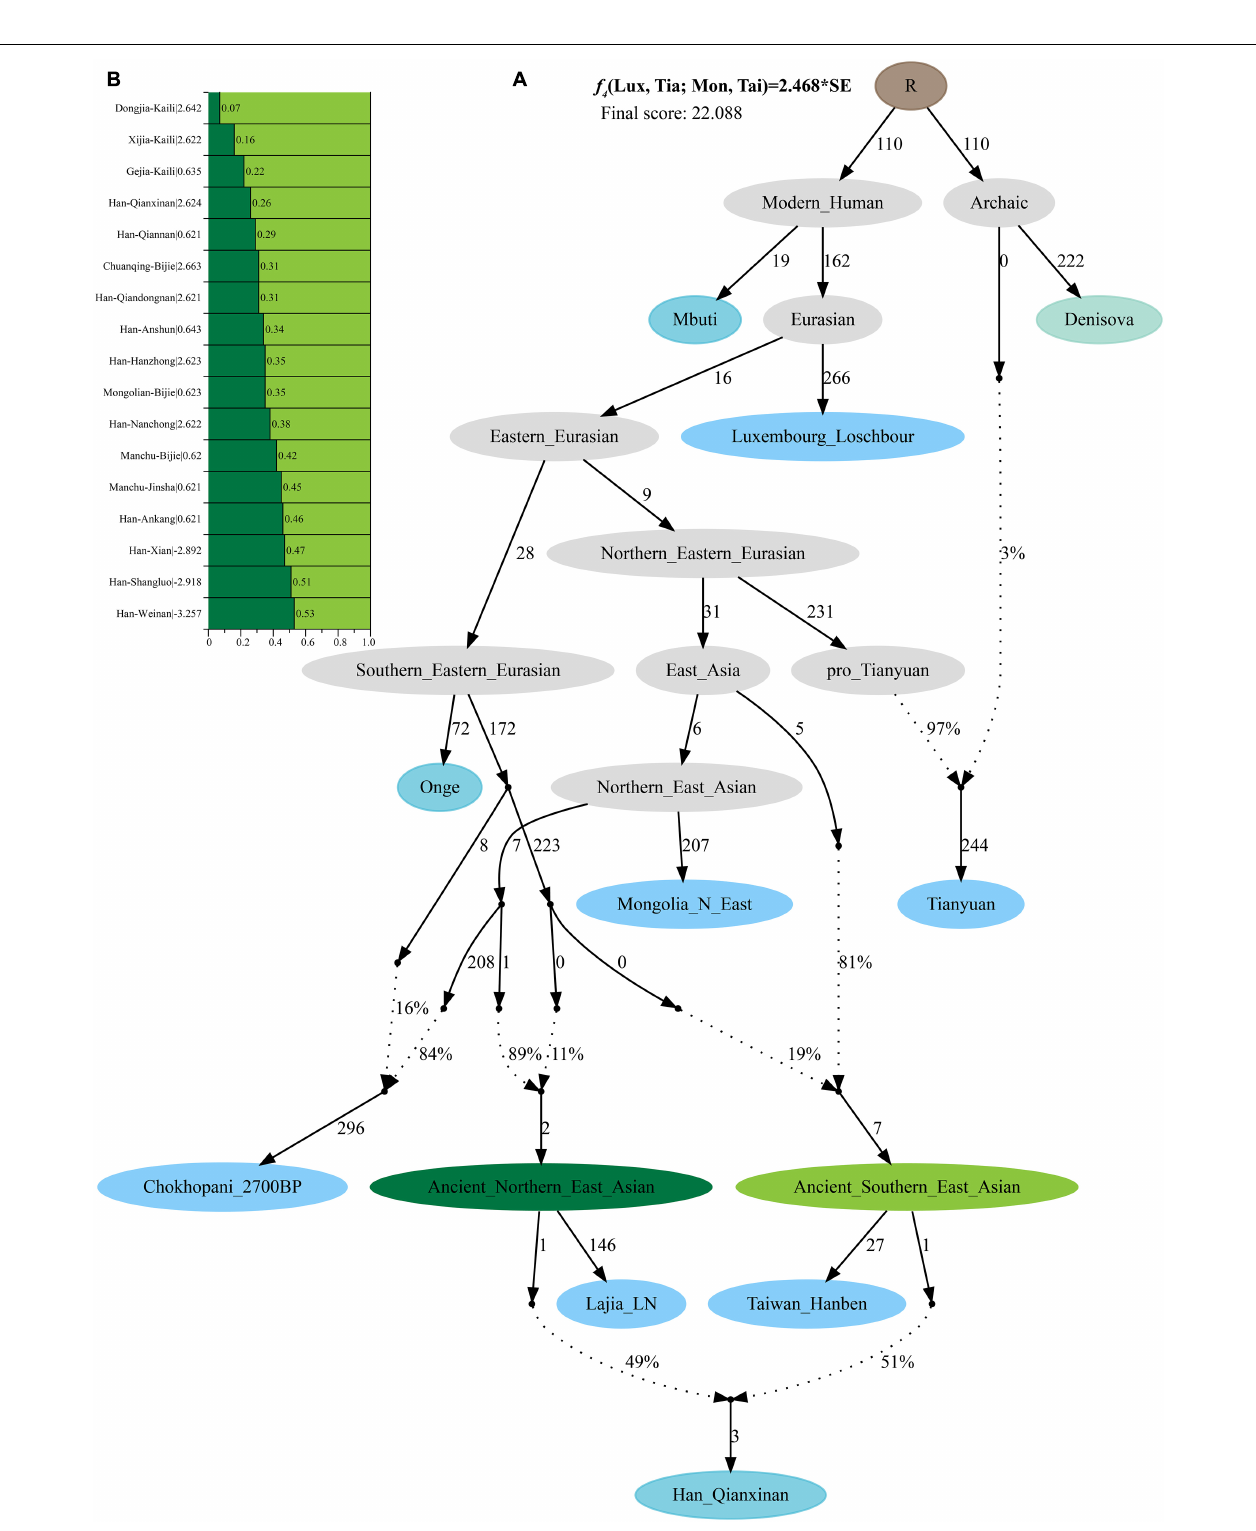
FIGURE 3 | Deep population admixture history reconstruction with the population splits and admixture events. (A) The qpGraph-based phylogenetic framework focused on the formation of Qianxinan Hans. (B) Admixture proportion and corresponding lowest Z -scores of the qpGraph models for other Hans and Guizhou aborigines. Different features of populations (ghost, archaic, ancient, and modern populations) were color-coded. Admixture events were denoted with dotted lines and marked the corresponding admixture proportion on it. Branch length was measured using f 2 -values (1,000 × ).